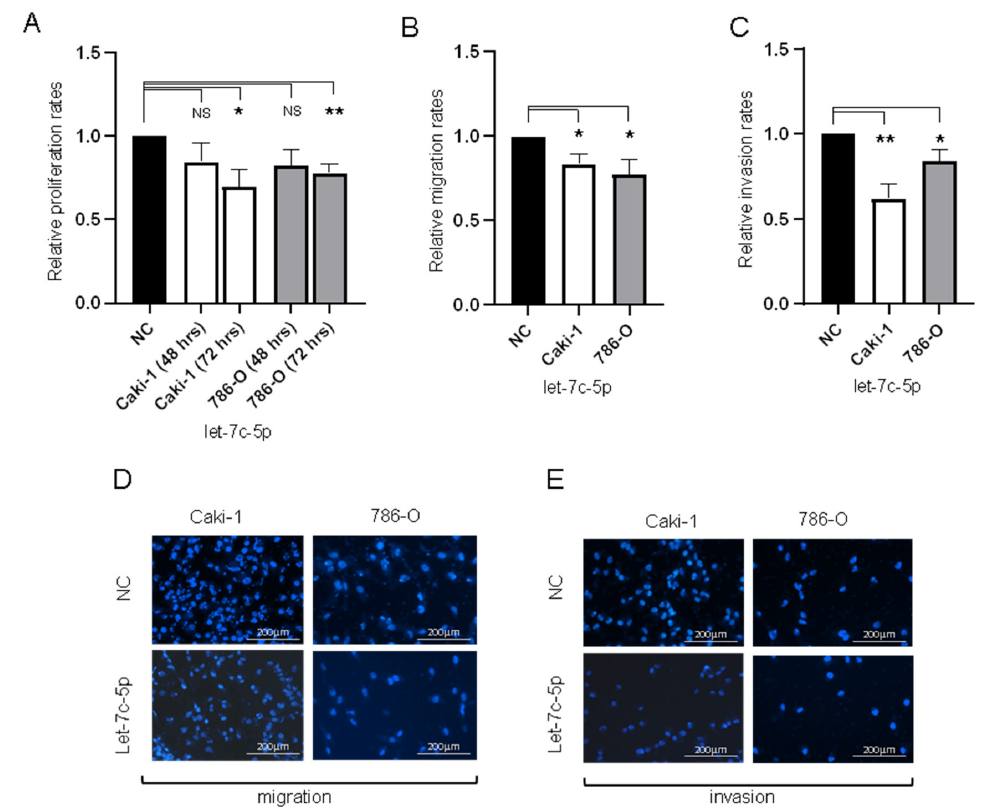
Figure 2. Influence of let ‐ 7c ‐ 5p transfection on cell behavior in Caki ‐ 1 and 786 ‐ O cells ( A ) Relative proliferation rates of Caki ‐ 1 and 786 ‐ O cells transfected with pre ‐ let ‐ 7c ‐ 5p compared to scramble negative control. ( B ) Relative migration rates of Caki ‐ 1 and 786 ‐ O cells transfected with pre ‐ let ‐ 7c ‐ 5p compared to negative control transfectants. ( C ) Relative invasion rates of Caki ‐ 1 and 786 ‐ O cells transfected with pre ‐ let ‐ 7c ‐ 5p compared to negative control. ( D ) representative images from the migration assay. ( E ) representative images from the invasion assay. In each case, the relative rates were decreased in cells treated with the let ‐ 7c ‐ 5p mimic. * p < 0.05, ** p < 0.01, and NS = not significant.